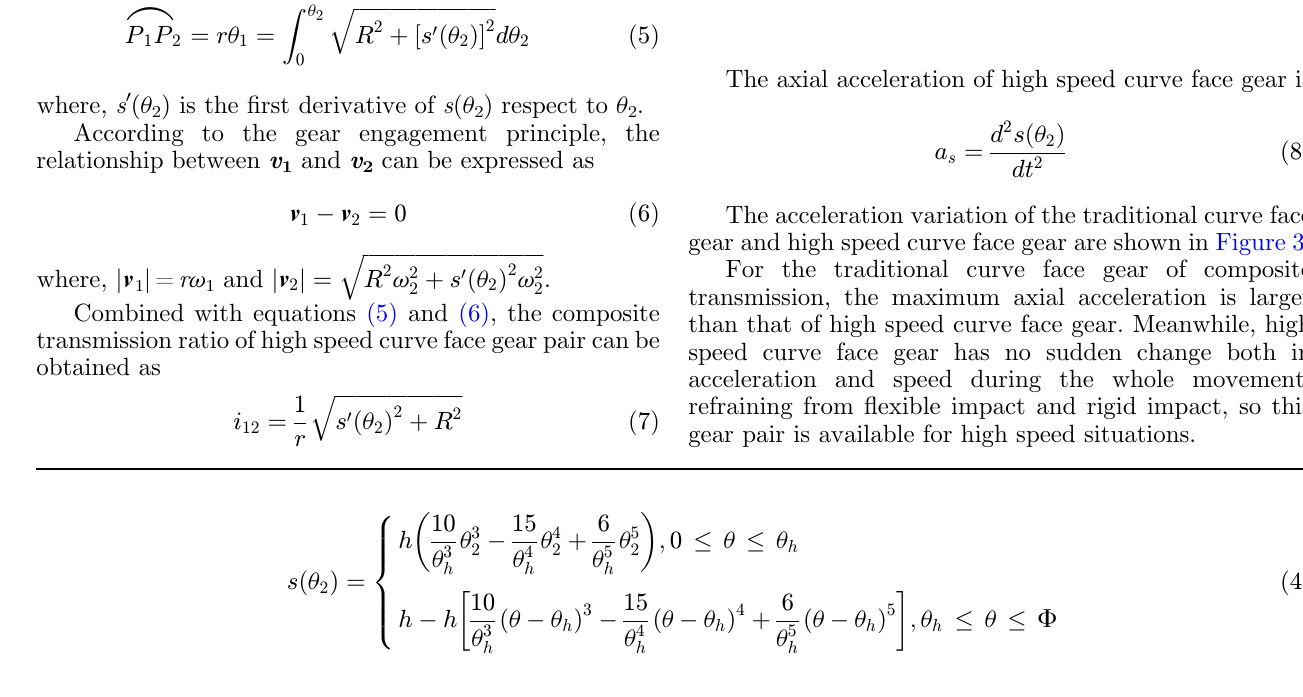
Fig. 3. Acceleration